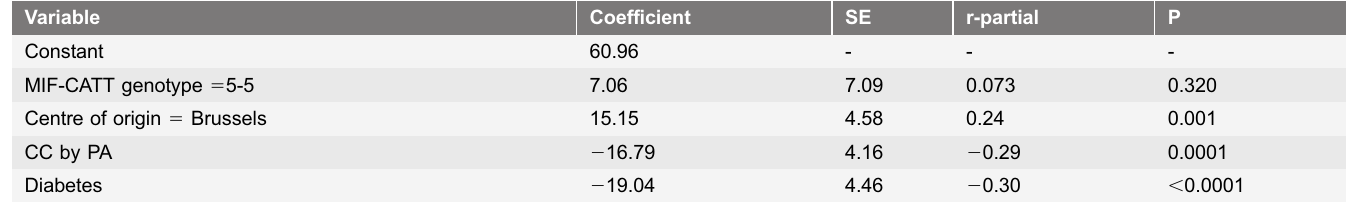
Table 4. Multiple regression analysis of FEV1 (Kulich)* data on 189 Cystic Fibrosis patients homozygous for the F508del mutation.